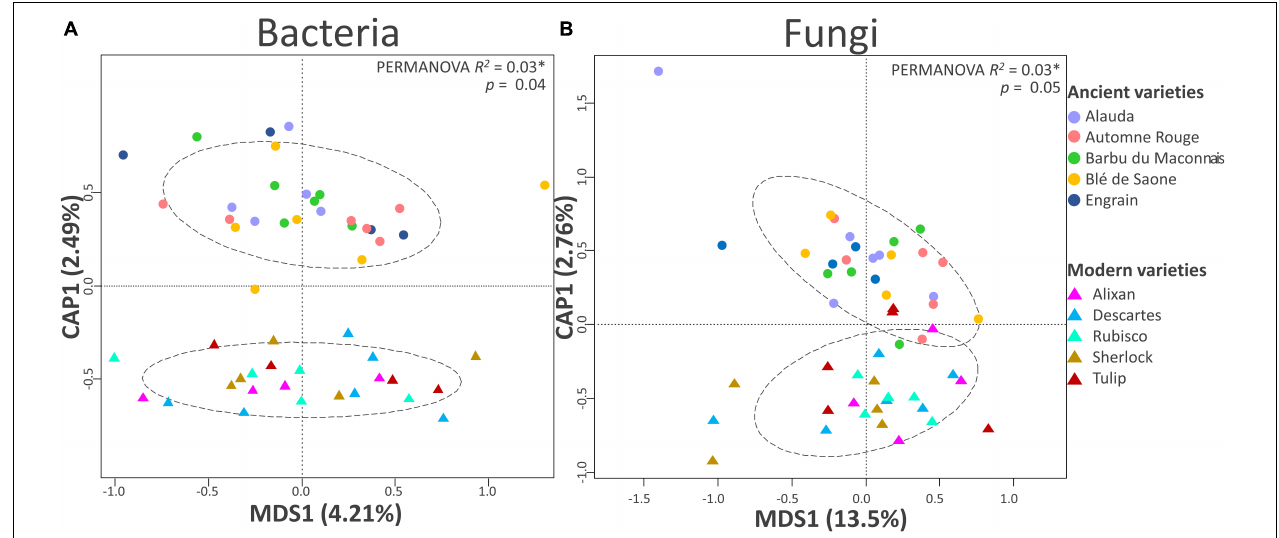
FIGURE 2 | Beta diversity analysis of the (A) bacterial and (B) fungal communities by partial distance-based redundancy analysis (db-RDA). Partial db-RDAs were conducted to output the following constrained models: breeding type + condition (block) (10,000 permutations, N = 24 for modern varieties; N = 27 and 26 for ancient varieties in the bacteria and fungi panels,